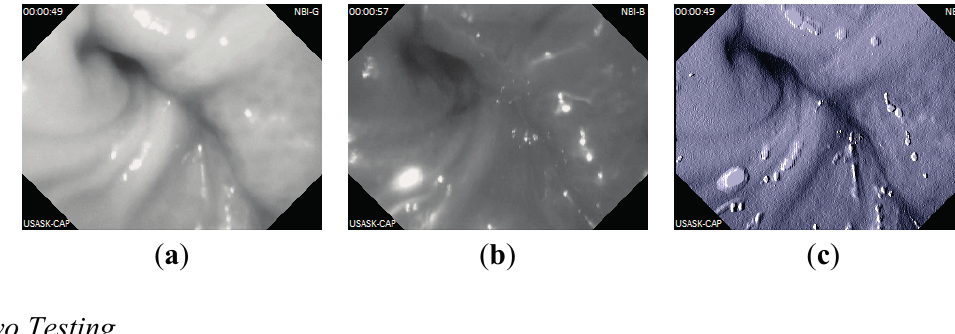
Figure 12. Captured NBI images from pig's intestine: ( a ) grayscale image with green light, CR = 84.31%; ( b ) grayscale image with blue light, CR = 84.11%; ( c ) Combined pseudo color NBI image from (a) and